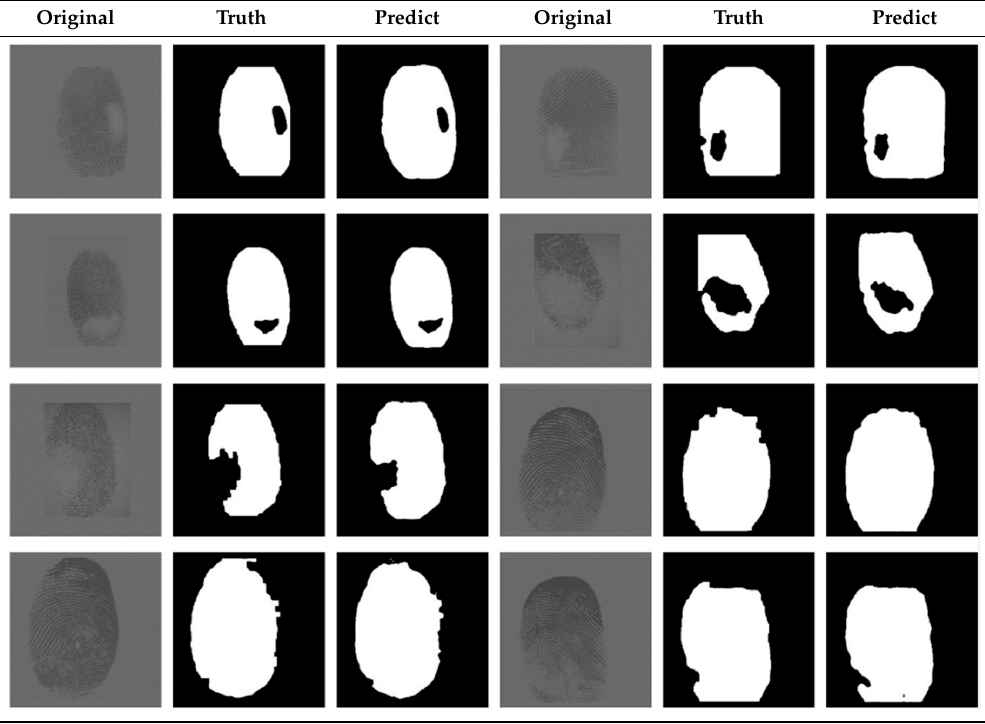
Figure 6. Train accuracy of XFinger-Net and ResU-net with epoch during